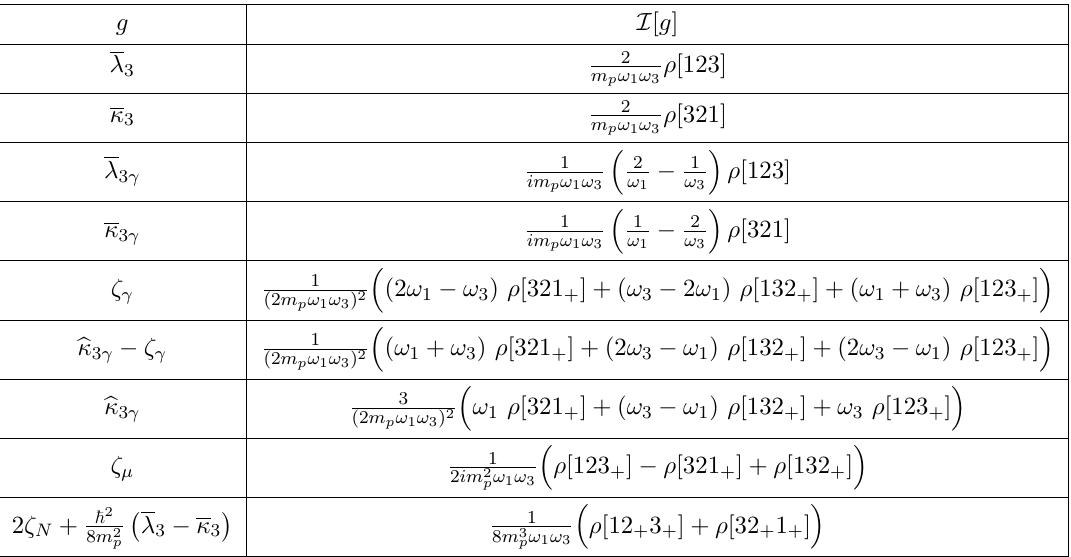
Table 4 . Cubic couplings: doublets/singlets under microscopic time-reversal (general environment).